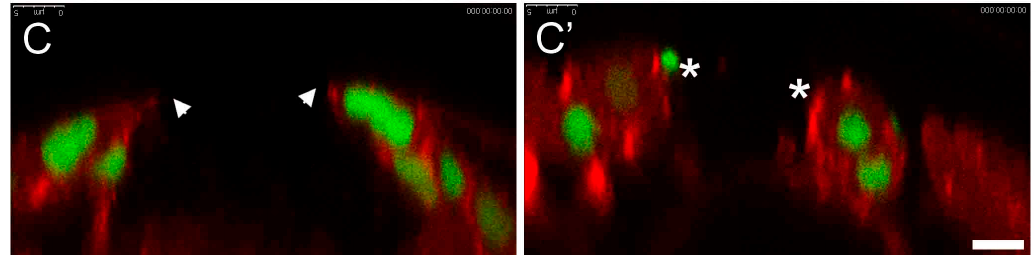
Figure 3. In src42A mutant embryos, cardioblasts with stalled migration lack leading edge membrane activity. The dynamic activity of the leading edge of migrating CBs was monitored in living embryos.